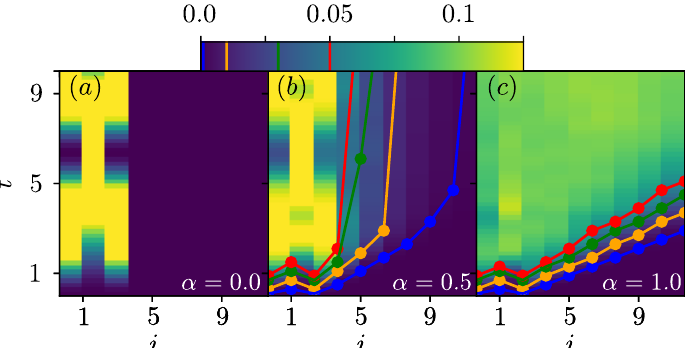
( i , t ) and L = 10. The oscillations at short distances for Figure 13: The α -OTOC C zx α small α and the long-distance decay are also visible for this OTOC.